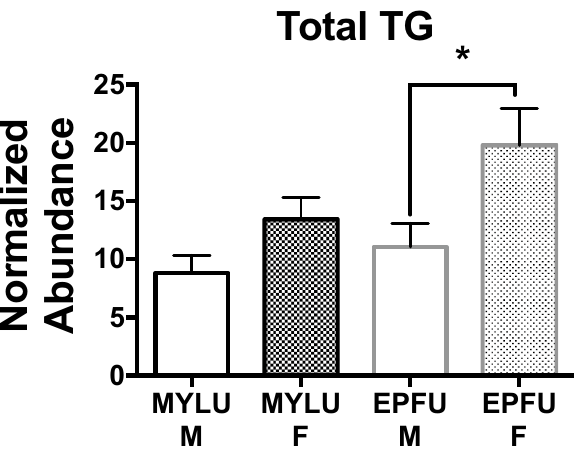
Figure 2. Total (> 1%) hepatic TGs in sham-inoculated Myotis lucifugus and Eptesicus fuscus . Eptesicus fuscus females had significantly higher concentrations of TGs compared to males. Myotis lucifugus females showed a moderate effect size for higher TG levels than males but not statistically significant. Mean ± S.E.M., * P ≤ 0.05, determined by a Welch’s t test, M. lucifugus (MYLU) n = 6 per group, E. fuscus (EPFU) n = 4 per